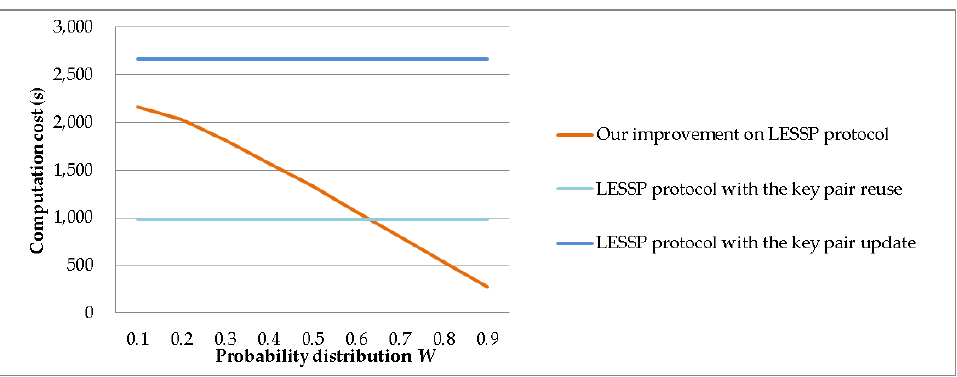
Figure 15. The computation time costs against probability distribution W .